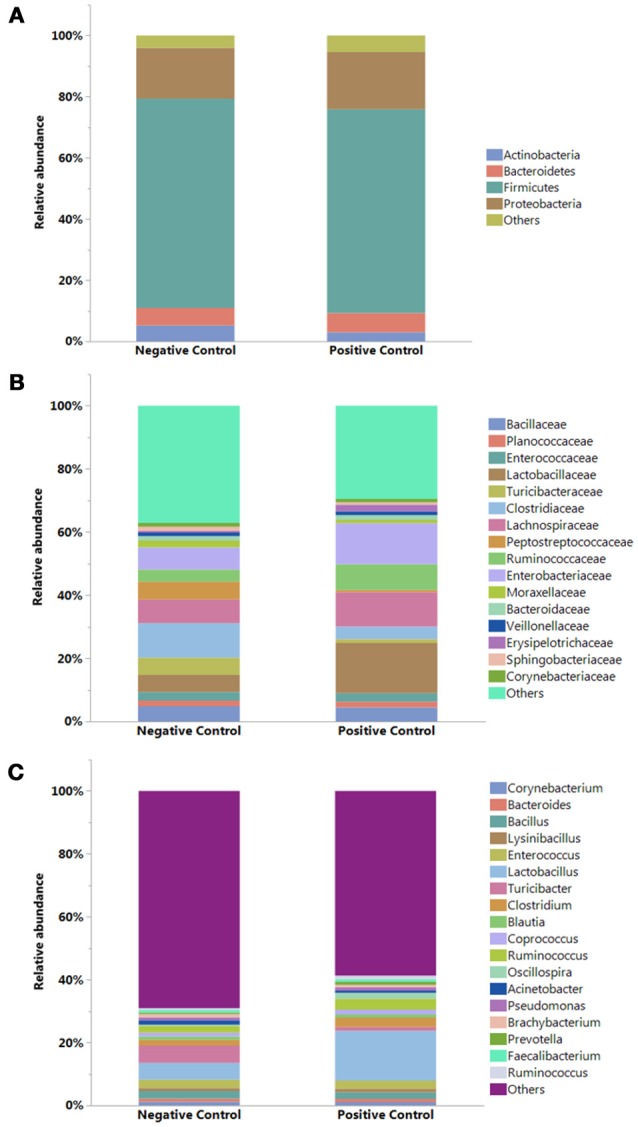
Relative abundance (%) of bacteria at (A) Phylum, (B) Family, and (C) Genus levels in the ileum of negative and positive control (with induced necrotic enteritis) groups. Minor bacteria genera including unassigned values were included as “others”.